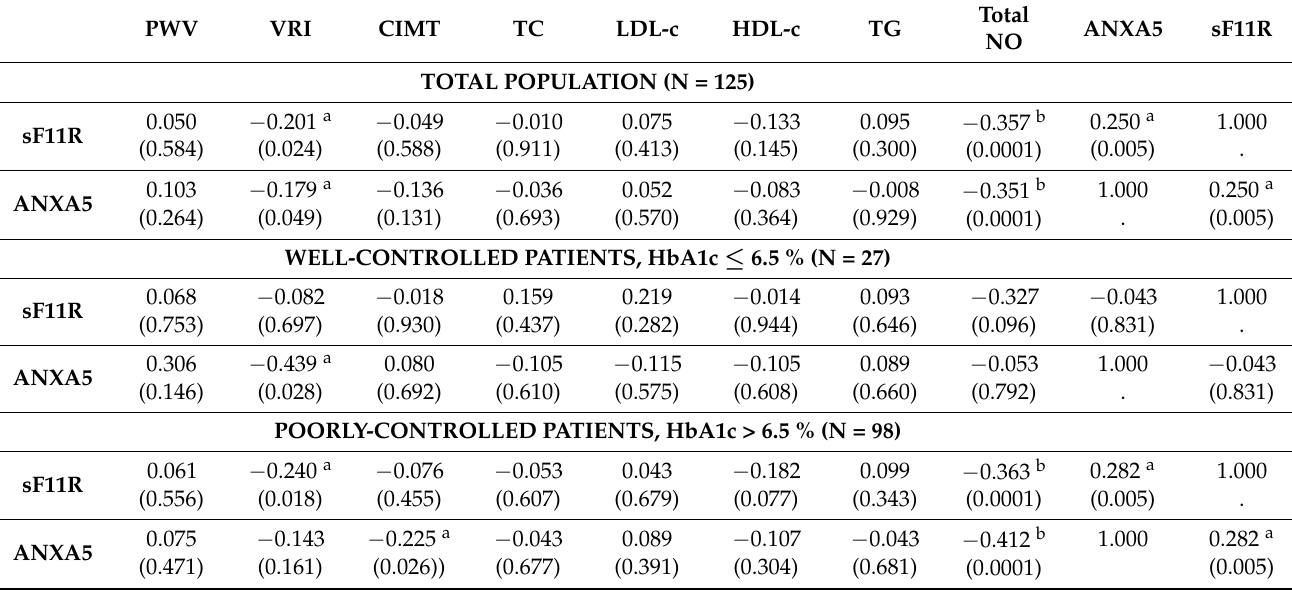
Figure 1. Frequency distribution of plasma sF11R and ANXA5 in the total population and stratified groups based on HbA1c levels. Levels of sF11R in the total population ( A ), and in well-controlled ( B ) poorly-controlled patients ( C ). Levels of ANXA5 in the total population ( D ), and in well-controlled ( E ) poorly-controlled patients ( F ). Table 2. Correlation between plasma sF11R and ANXA5 levels with vascular outcome and lipid parameters in the total population and stratified groups based on HbA1c